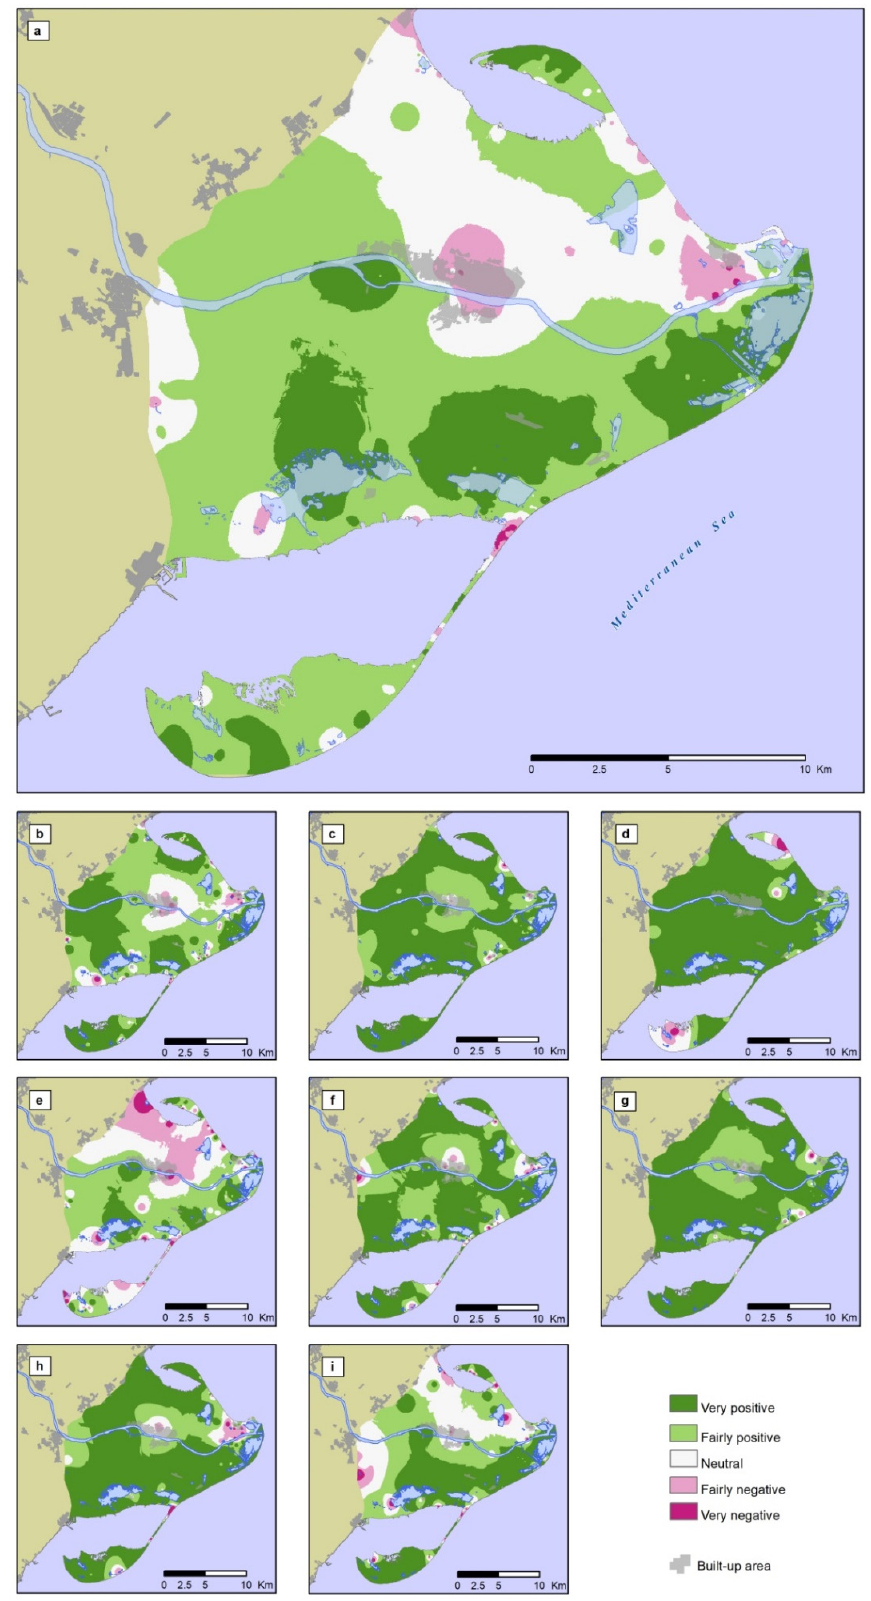
Figure 4. Spatial interpolation of respondent opinions: ( a ) multi-criteria evaluation; ( b ) naturalness; ( c ) attractiveness; ( d ) productiveness; ( e ) cleanliness; ( f ) peacefulness; ( g ) interest; ( h ) silence; ( i ) neatness.